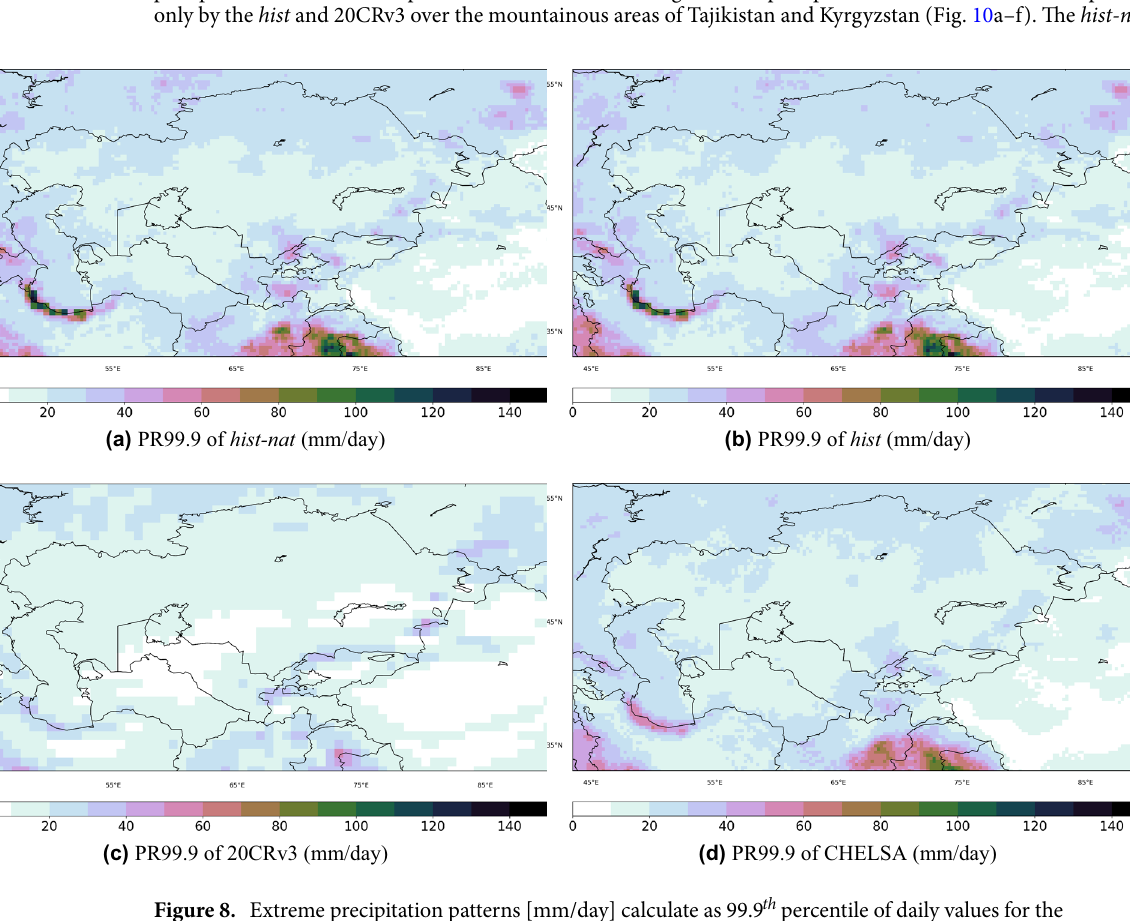
th percentile of daily values for the